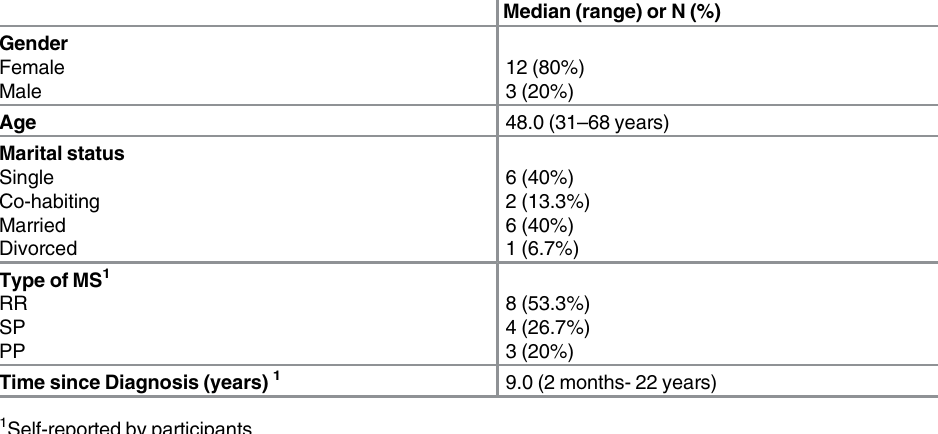
Table 1. Participant